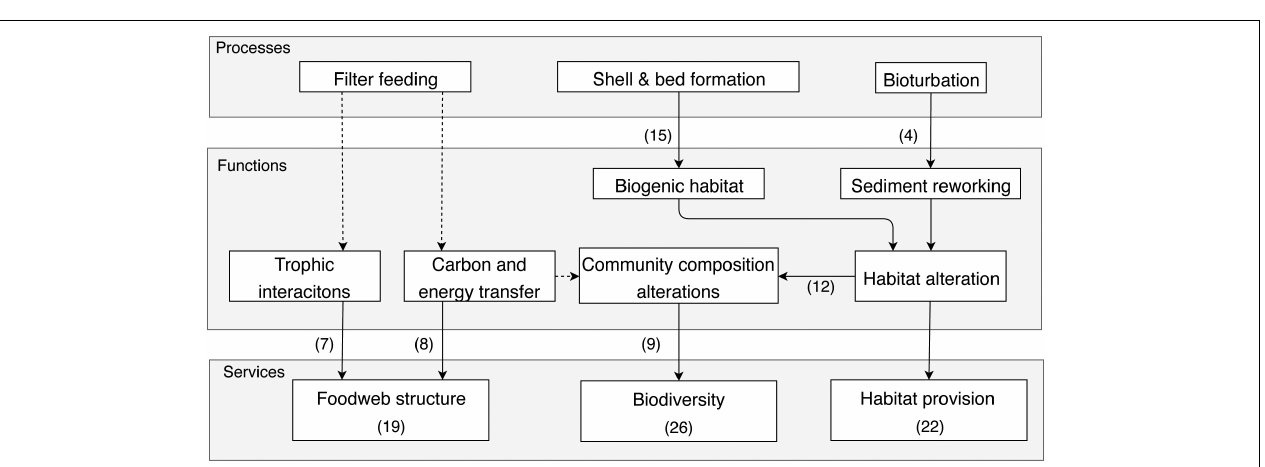
FIGURE 5 | Simplified cascade showing the links between processes, functions, and services in the Habitat modification bundle. The number of papers discussing a service is indicated in brackets within the service box, while the number of times links between processes and functions were discussed is indicated in brackets next to the arrows.